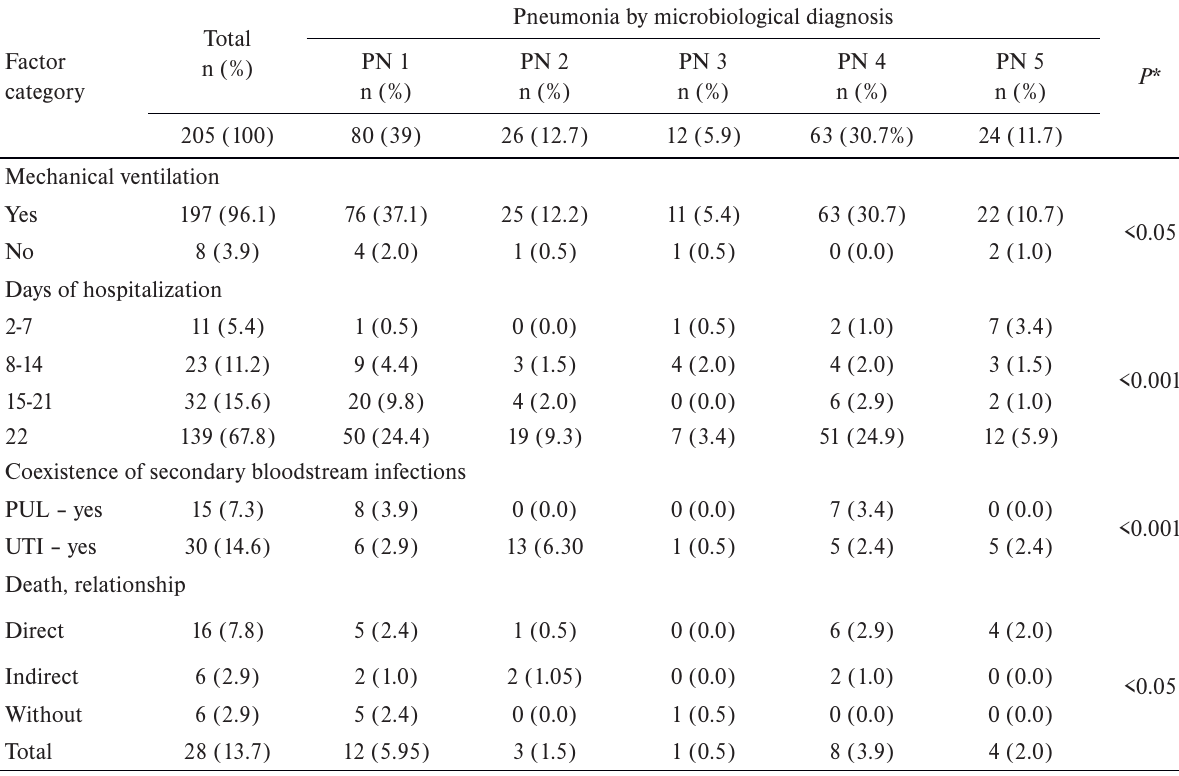
Table 1. Multivariate analysis of healthcare-associated pneumonia and types of